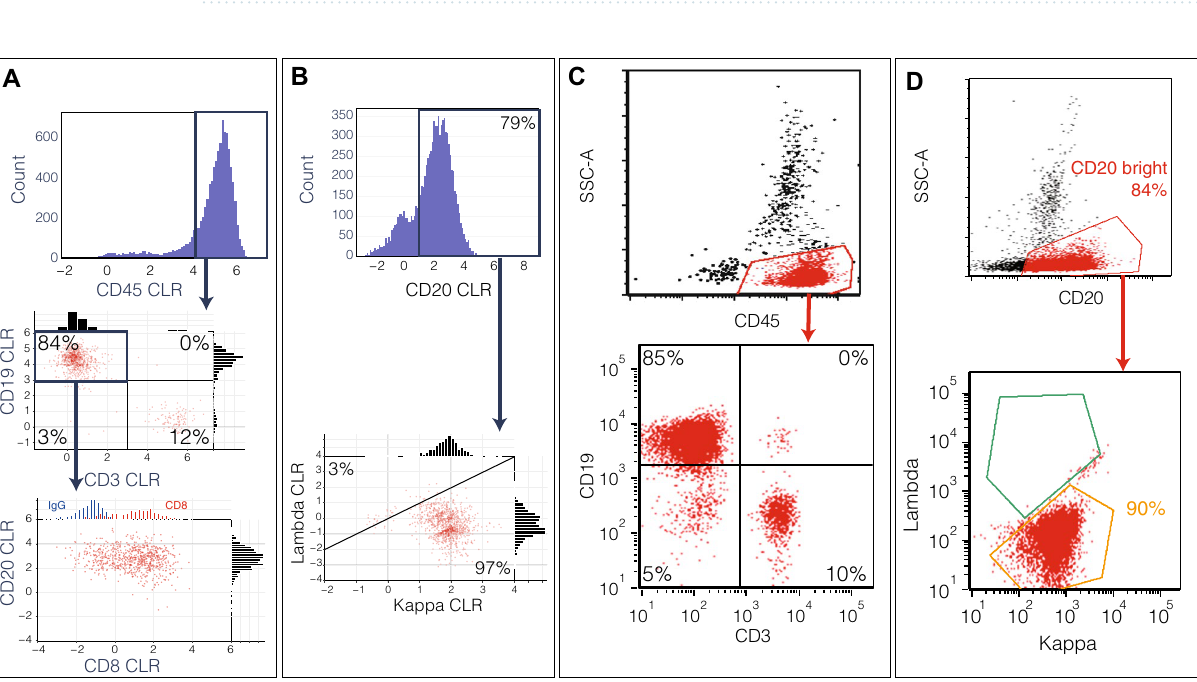
Figure 4. QBC2 CLR-transformed antibody scores and flow cytometry from patient 1 bone marrow sample. ( A ) Cells from patient 1 are gated for CD45+ expression. Further stratification of B-cells in this population shows that CD19+ CD3− gated B-cells show B-cells that have moderate CD8 expression (red) (isotype control expression on CD20+ cells in blue for comparison). ( B ) CD20+ gated B-cells show a pathological expansion of the kappa light chain population. ( C ) Flow cytometry data for the same sample. Monocytes, granulocytes and lymphocytes are identified; lymphocytes are gated for downstream analysis. Population proportion of CD19+ CD3− as identified in flow cytometry similar to QBC2 (85% and 84%, respectively, from panel A ). ( D ) Bright CD20 expression gated to capture B-cell population. Flow cytometry demonstrates a kappa restricted B cell population, concordant with clonal expansion identified in